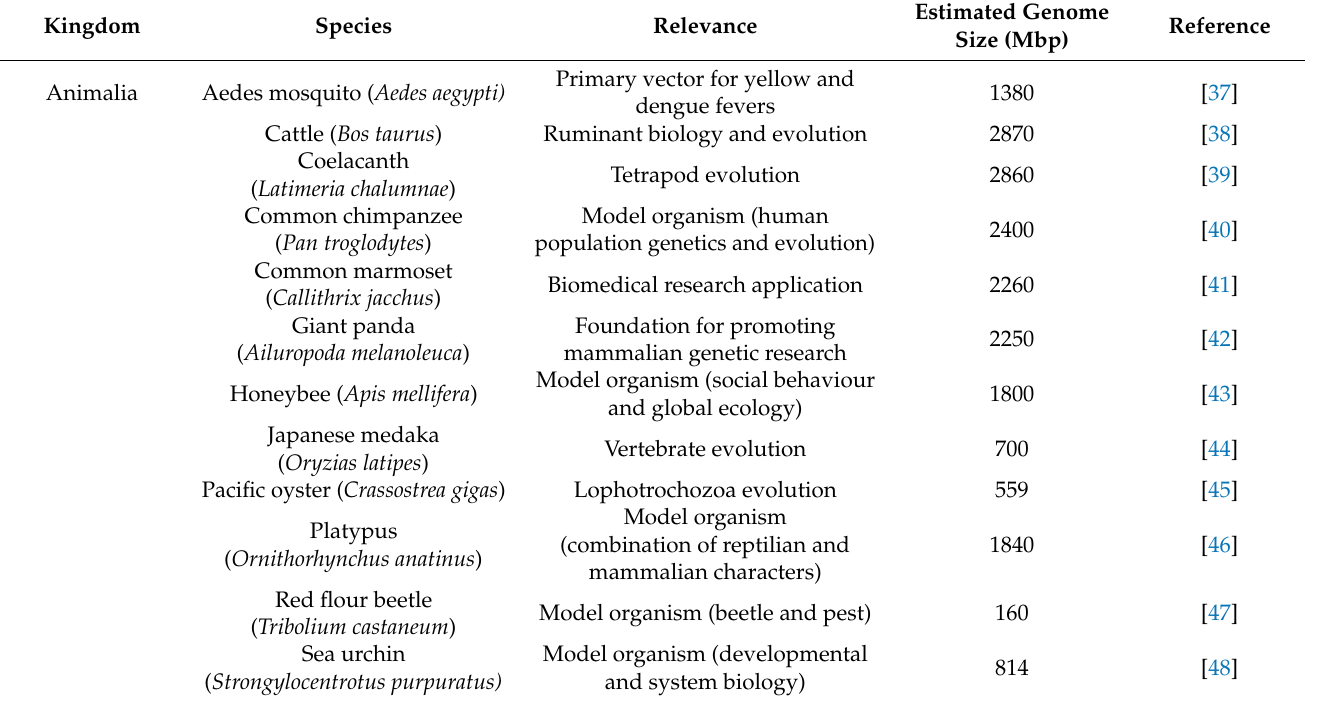
Table 1. Examples of multicellular organisms with well-annotated